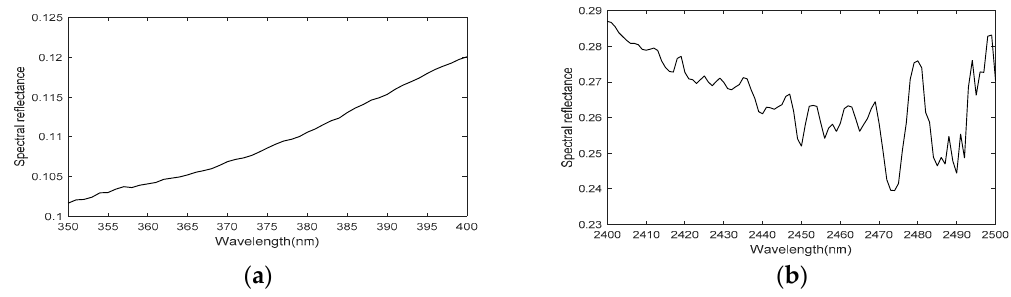
Figure 3. Peripheral band spectrum curve: ( a ) 350–399 nm; ( b ) 2401–2500 nm.